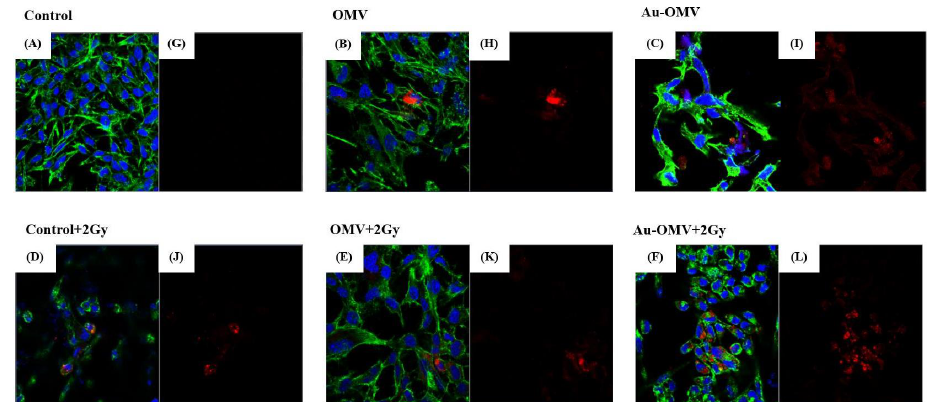
Figure 4. Confocal microscopy of immunofluorescence imaging of the GL 261 glioma cells co-cultured with RAW 264.7 macrophages. ( A , G ) Control and treatments with ( B , H ) OMV, ( C , I ) Au–OMV, ( D , J ) 2 Gy X-ray, ( E , K ) OMV + 2 Gy X-ray, and ( F , L ) Au–OMV + 2 Gy X-ray. ( immunofluores- cences: H33342/DAPI (blue for nucleus), phalloidin (green for actin), and VybrantTM DiD (red for macrophages).